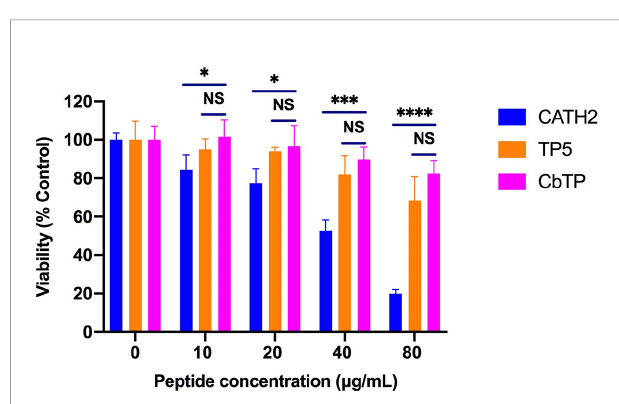
FIGURE 4 | Cell viability of RAW264.7 macrophages. Cells were treated with various concentrations of peptides and incubated overnight at 37°C and 5% CO 2 . Cell proliferation rates were measured by microplate at 450 nm using CCK8 assay. Statistical comparisons were performed by Student ’ s t test. Data are given as the mean ± standard deviation (n=5). NS: p > 0.05, *p ≤ 0.05, ***p ≤ 0.001, and ****p ≤